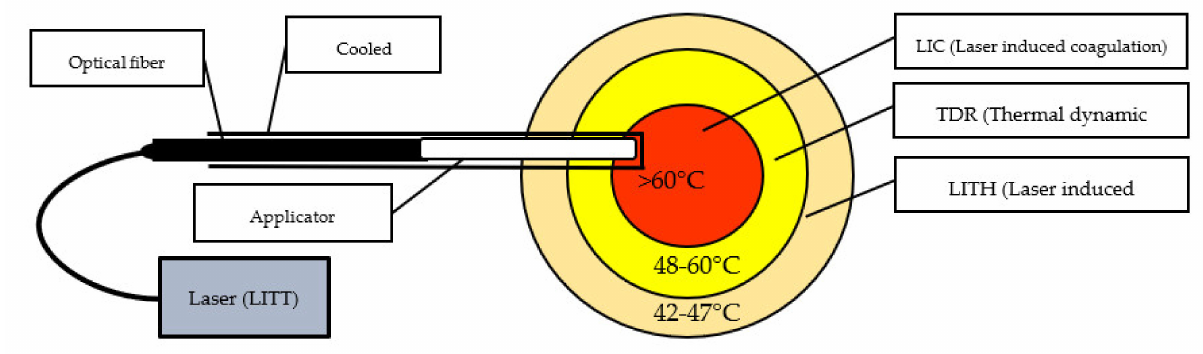
Figure 2. Graphic representation of photothermal mechanisms in laser-induced thermal therapy